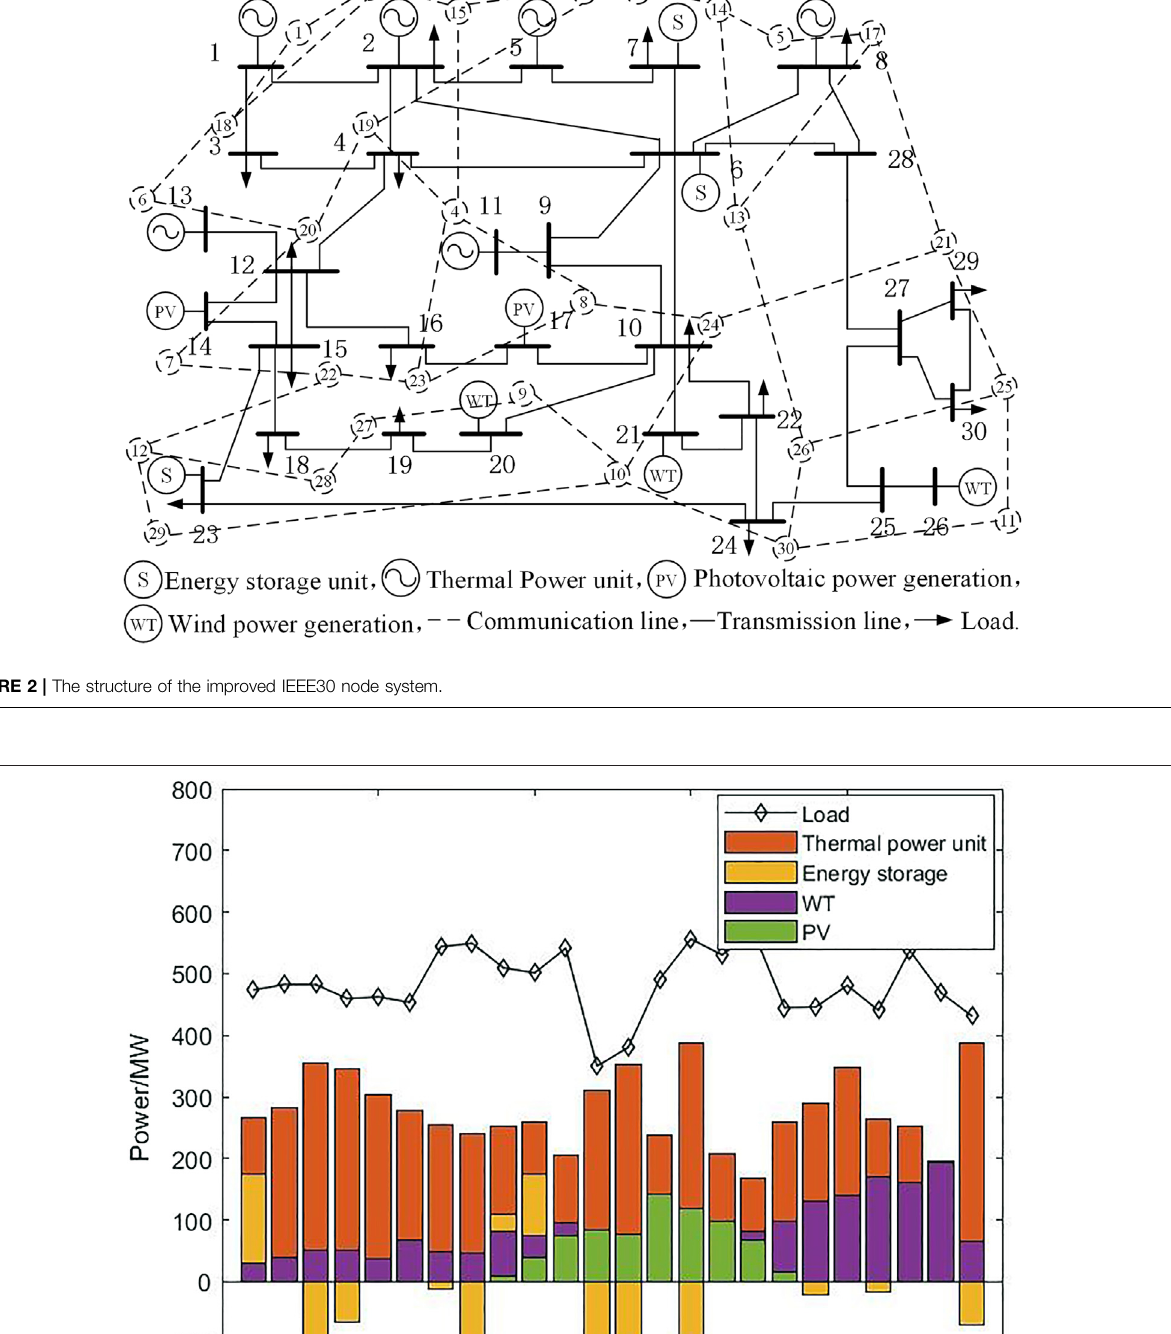
Frontiers in Energy Research |